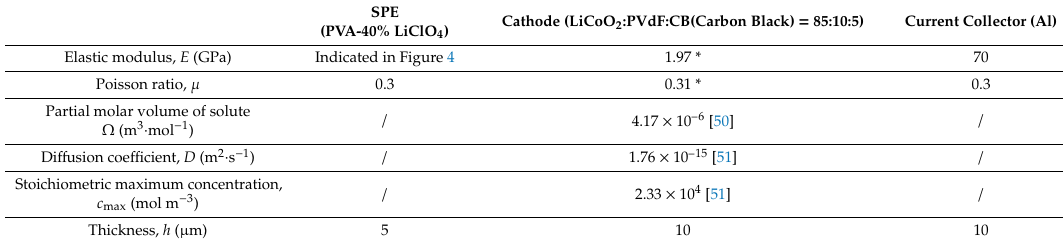
Figure 8. Effect of aging time on the ( a ) stress profile across the SPE and ( b ) peak SPE stress. Table 1. Sets of material parameters used in